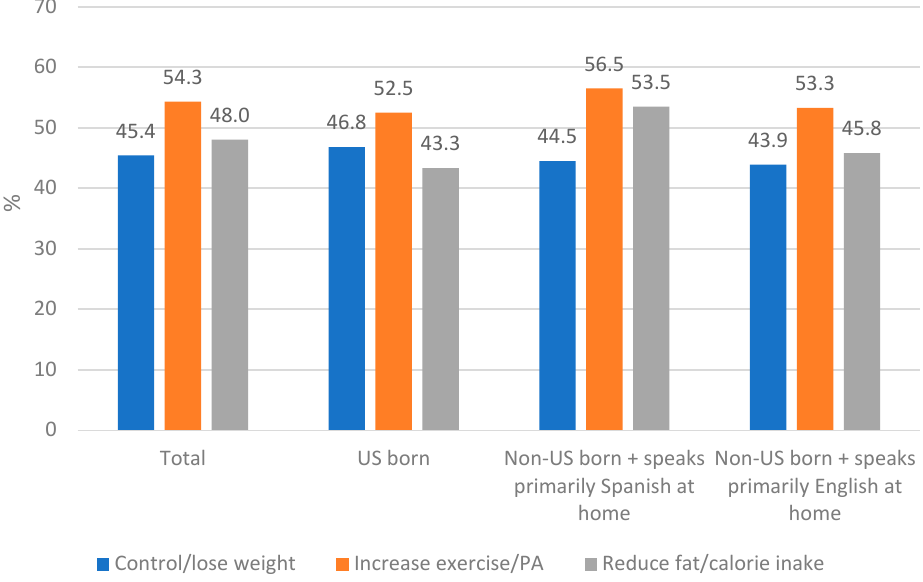
Figure 1. Receipt of healthcare provider counseling according to acculturation level. Table 2. Comparative odds ratios of receiving health care provider (HCP) counseling by acculturation level.